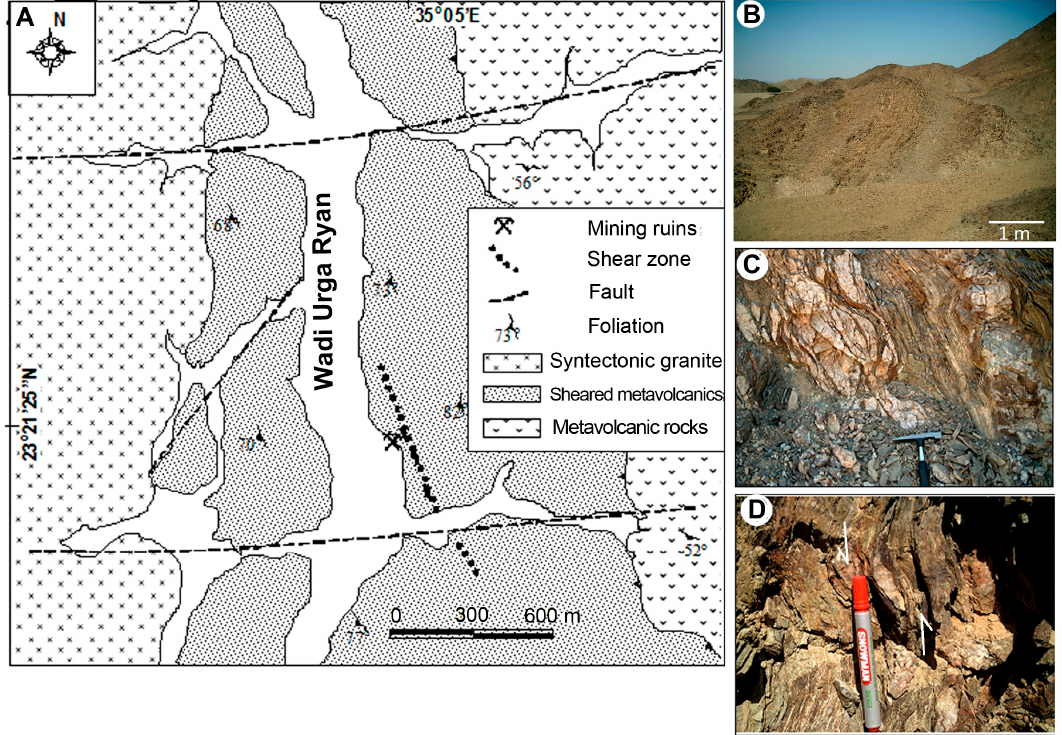
Figure 16. ( A ) Simplified geological map of the Urga Ryan gold occurrence (compiled from satellite-imagery data coupled with our fieldwork), ( B ) moderately dipping, strongly foliated, and sheared metavolcanic rocks at the Urga Ryan gold mine with zones of discoloration due to variable hydrothermal alteration distal and proximal to the gold-bearing veins; ( C ) boudinaged quartz lenses along the shear zone surrounded by ferruginated, sericitized wallrocks; ( D ) lensoid (sigmoidal) quartz lenses indicating sinistral sense of shear along the host shear zone. Inclined slickensides on the vein wall surfaces suggest that movement was oblique with lateral and vertical components.